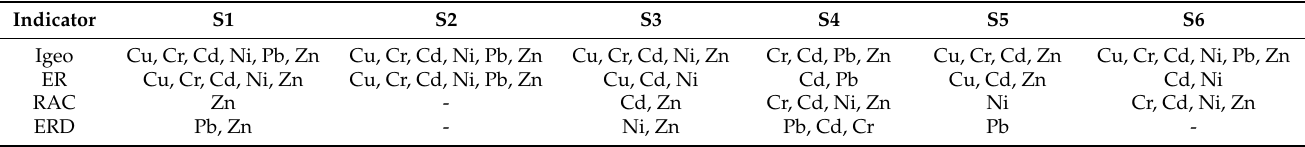
Table 8. Table of non-compliance with heavy metal toxicity criterion from analysed sites by pollutant indicators. Indicator